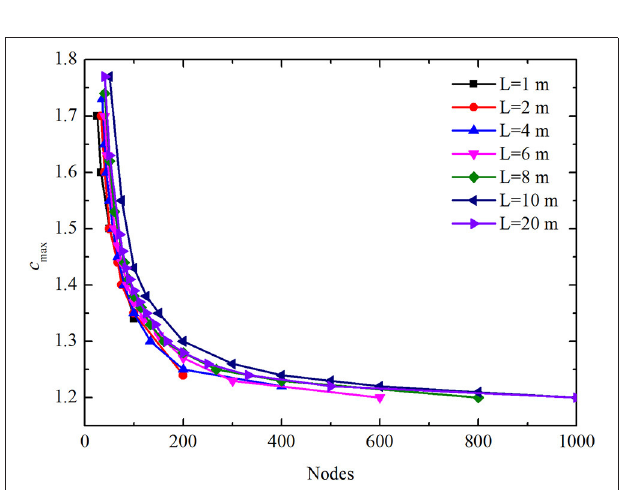
FIGURE 14 | Relationship between temperature and time without considering CFL condition.